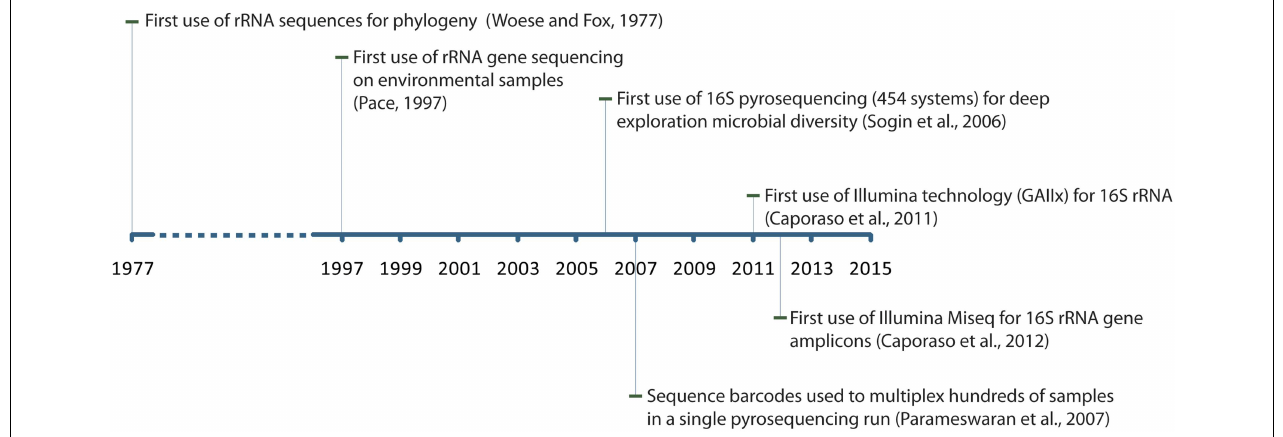
FIGURE 1 | Timeline indicating major breakthroughs in experimental and theoretical work in the field of 16S rRNA gene sequencing.